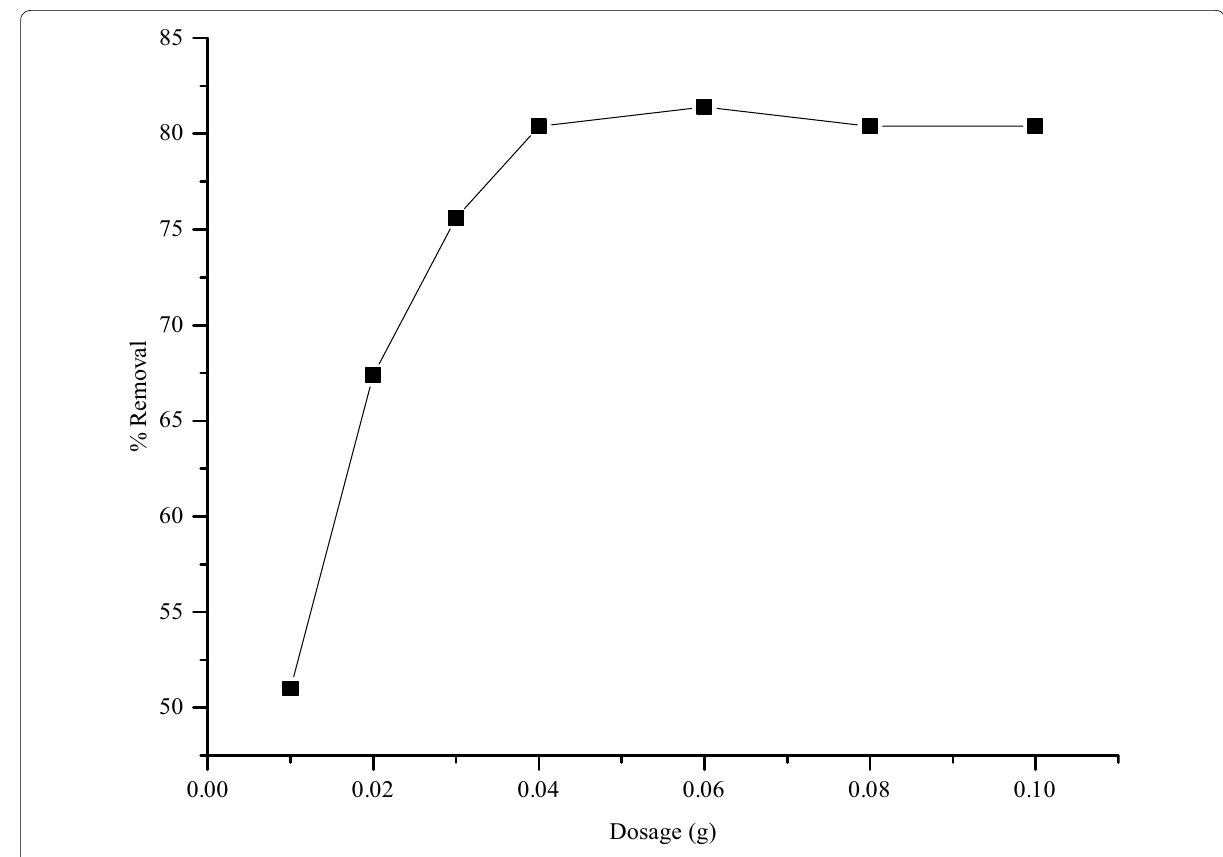
240 mg/L; temperature =